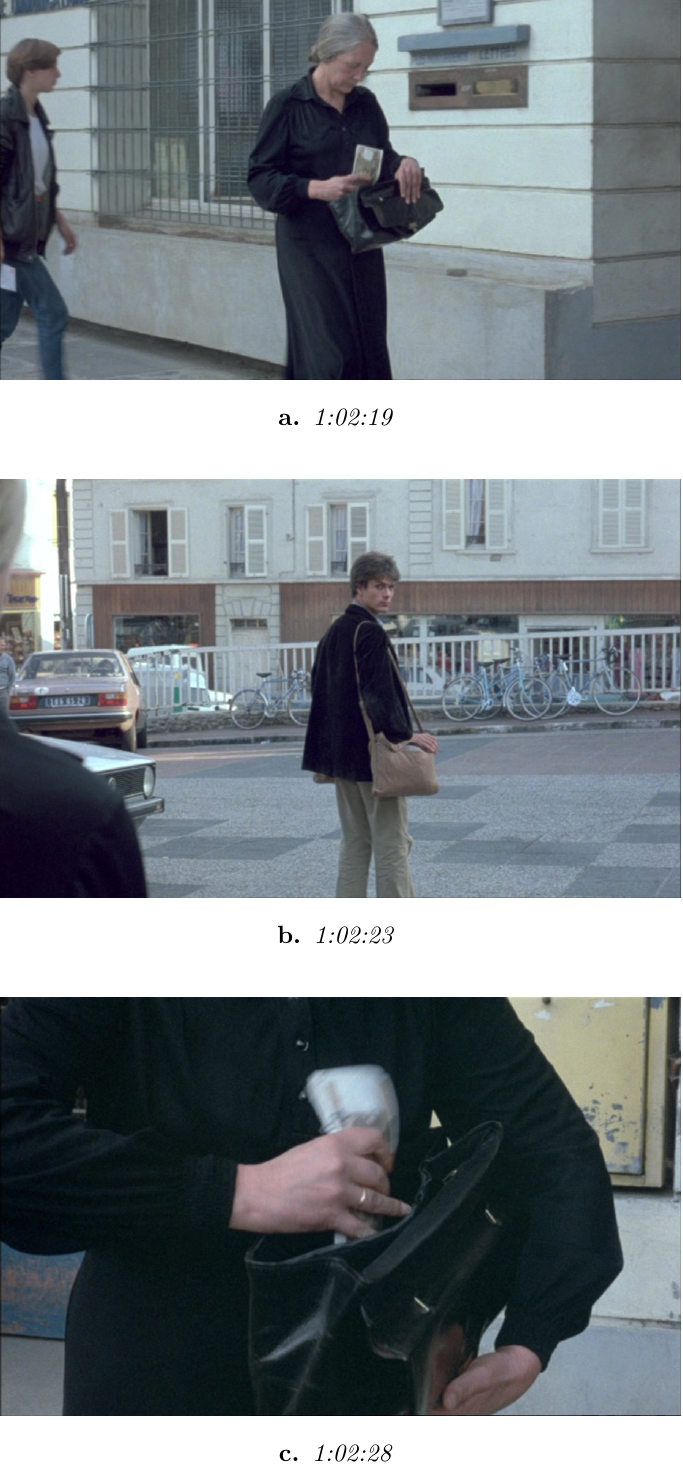
Figure 3: Three shots juxtaposed in Ł’Argent , with affordances due to the psycho- logical repertoire of the woman – we see her seeing these